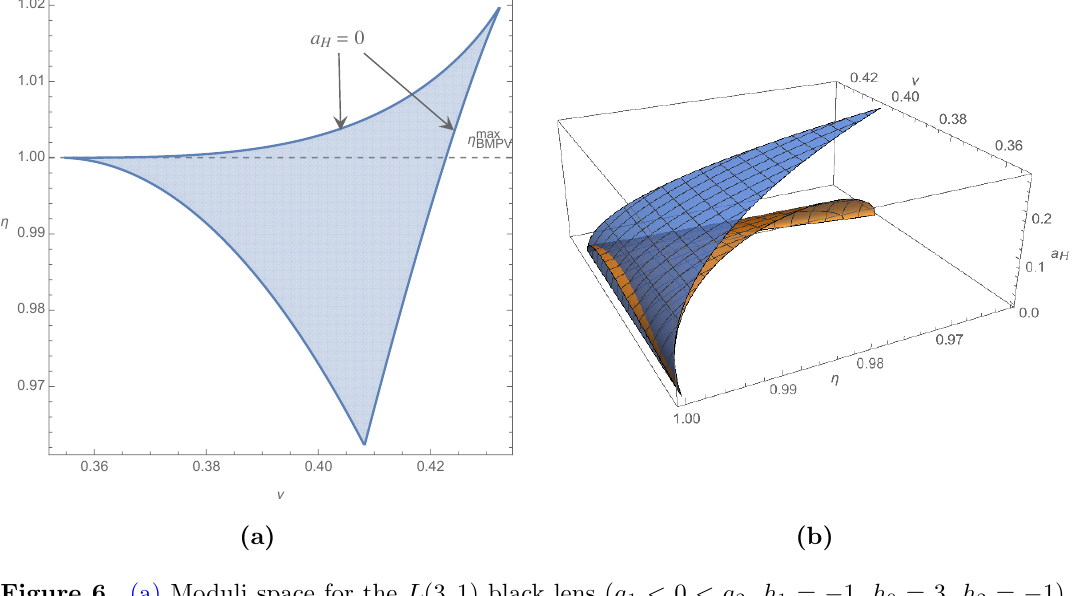
Figure 6. (a) Moduli space for the L (3 ; 1) black lens ( a 1 < 0 < a 2 , h 1 = (cid:0) 1, h 0 = 3, h 2 = (cid:0) 1), with J (cid:30) = 0. (b) Dimensionless area of the black lens (orange/lighter) and of the BMPV black hole (blue/darker), within the region of overlap. Observe that a H > a BMPV in a narrow region close to (cid:17) =